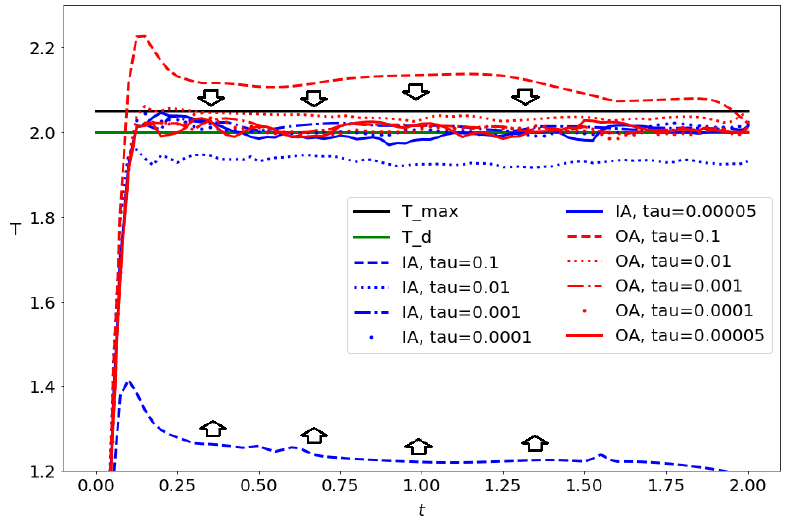
Figure 8. Maximum values of E [ T ∗ ( u ∗